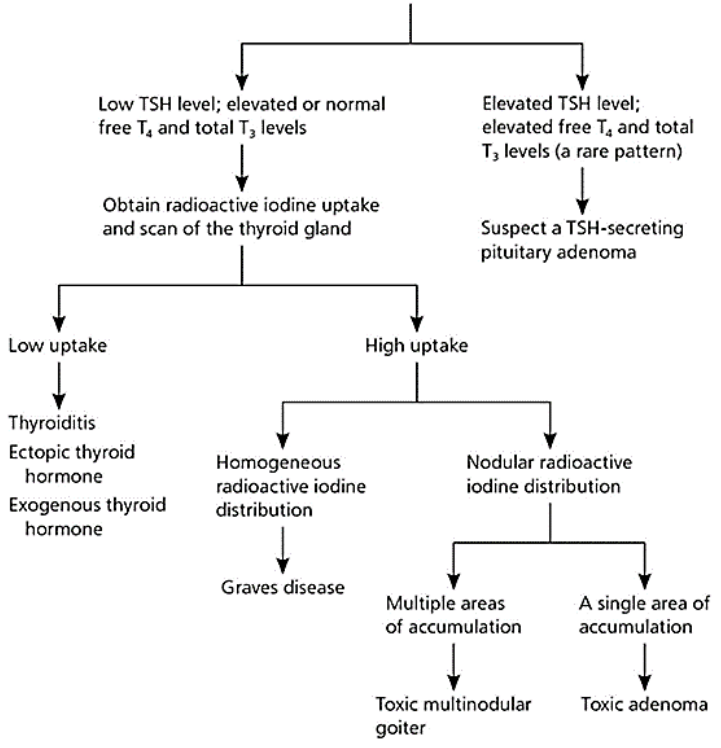
Figure 1. Algorithm for hyperthyroidism diagnosis T3, triiodothyronine; T4, thyroxine; TSH. thyroid-stimulating hormone Source: reference no